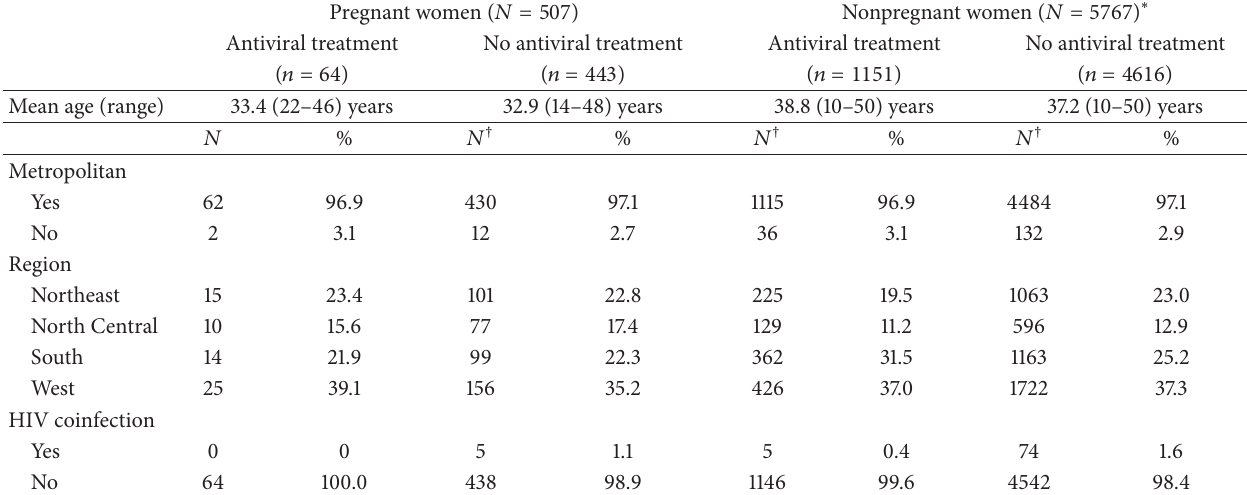
∗ The differences between nonpregnant women with and without antiviral treatment were statistically significant for age, region, and HIV status at 𝑃 < 0.01 . † Percentages were of total subjects: due to missing or invalid data, the sum of some subcategories and their associated percentages do not equal 100. Table 3: Proportion and types of antiviral agents received by women age 10–50 years with chronic hepatitis B virus infection.